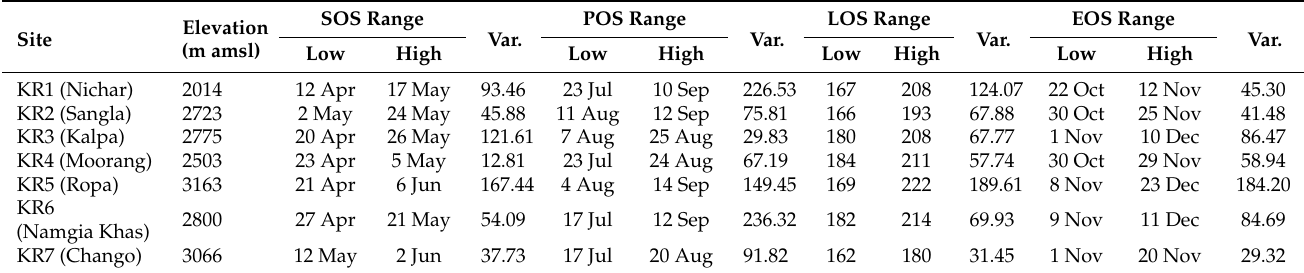
Table 3. Extremes of seasonal variations in the selected